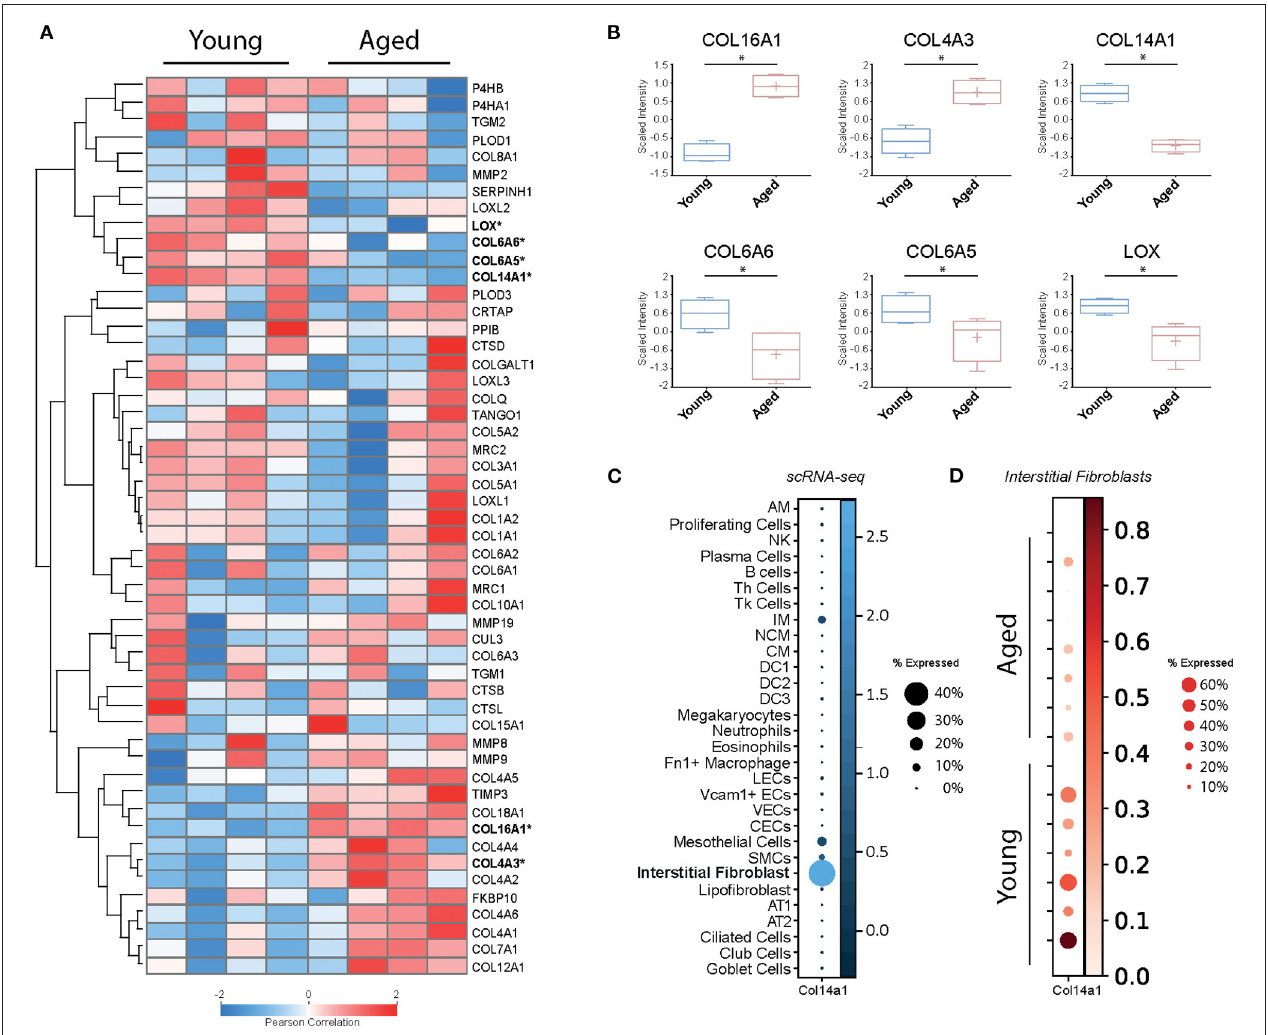
FIGURE 5 | Baseline changes of proteins involved in collagen biosynthesis, trafficking, processing, and degradation. (A) Heatmap of normalised mean intensity values of 52 regulated extracellular matrix proteins (whole lung proteome, mass-spec) grouped by unsupervised hierarchical clustering and Z -scored (Pearson’s correlation). (B) Boxplots of 6 significantly regulated proteins with age. (C) The dot plot shows mRNA expression specificity of Col14a1 in scRNA-seq data of whole lung homogenate. (D) Dotplot indicating mRNA expression levels between aged and young mice within the lung interstitial fibroblasts cluster (* = Student’s t -test significant, FDR <